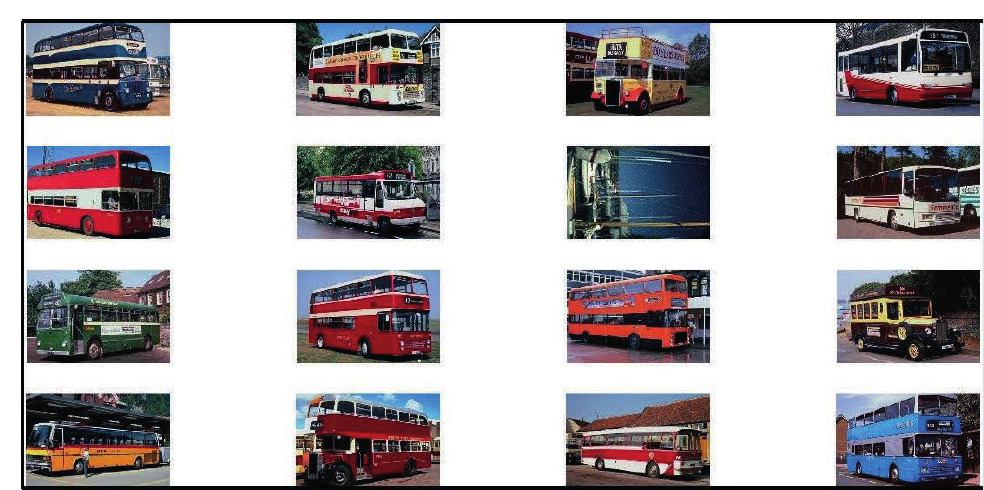
Fig. 22. Bus images retrieved using Framework-3 (EHD-CLD).